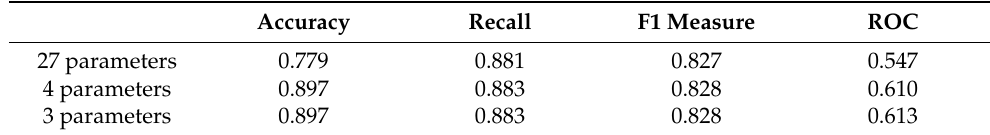
Table 9. Result evaluation of LogitBoost classification using all 27, 4 and 3 parameters.